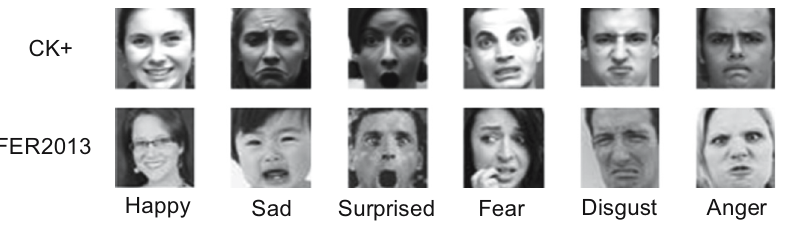
Figure 5: Example of the CK + dataset and FER2013